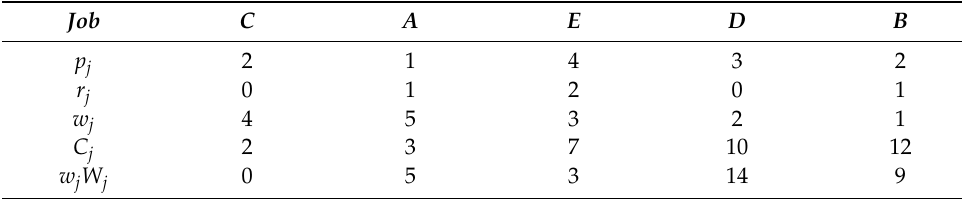
Table 2. Optimal solution for the initial problem.